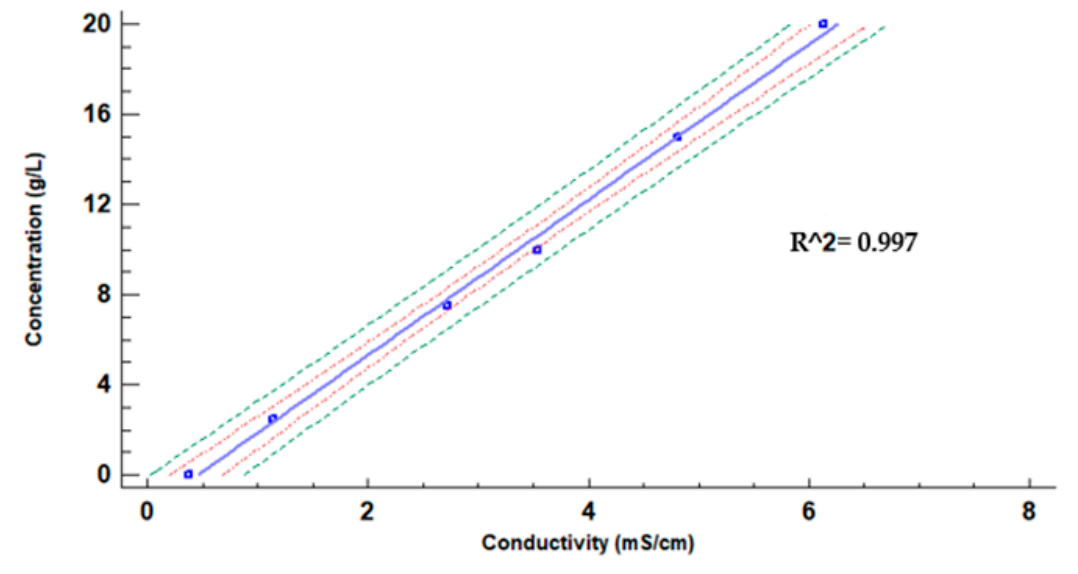
Figure 5. Tight model for OF concentration (g / L) vs. conductivity (mS / cm).